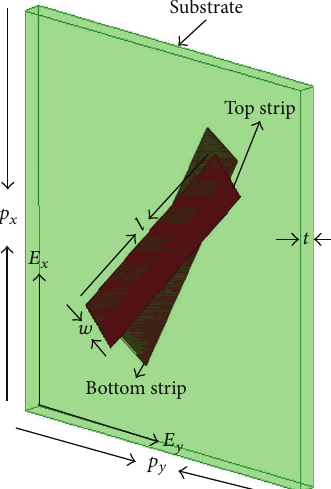
Figure 1: Schematic view of dual-band circular polarizer unit